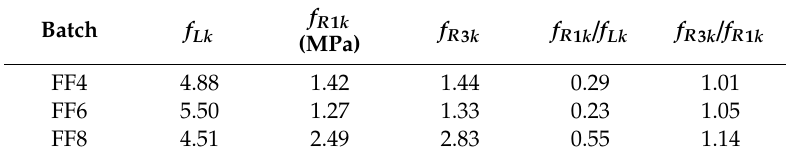
Table 6. Summary of the 28-day characteristic values of all batches according to the fib Model Code 2010.